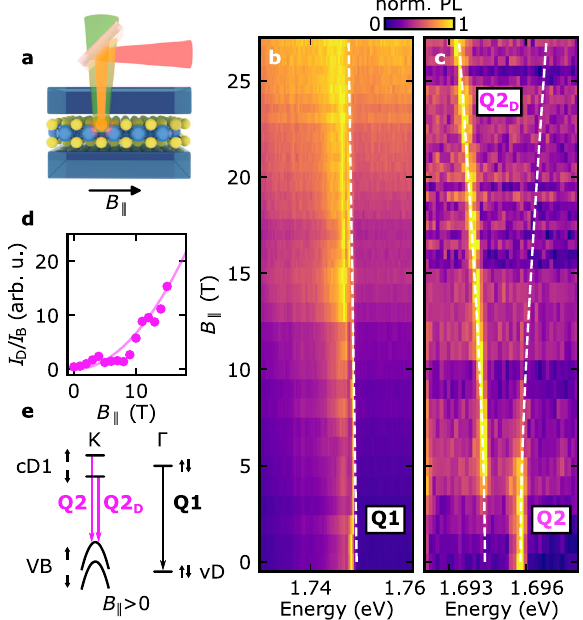
Fig. 4 In-plane magnetic fi eld B ∥ measurements on the photo- luminescence of defect luminescence Q1 and Q2. a Sketch of the in-plane magnetic fi eld B ∥ con fi guration (Voigt Geometry). No polarization optics were used in the detection path. b Emission of Q1 remains bright for all fi elds. c The in-plane fi eld reveals a second state Q2 D energetically below Q2. The white dashed lines are guides to the eye for the expected in-plane Zeeman shift of Q1 and the dark-bright-splitting of Q2. The dark-bright splitting Δ DB = 1.4 meV for Q2 is calculated with Eq. (2). d The quadratic dependence of the emission ratio between Q2 D and Q2 indicates the brightening of a dark ground state. e Sketch of the defect levels with the possible optical transitions for Q1 and Q2 at fi nite B ∥